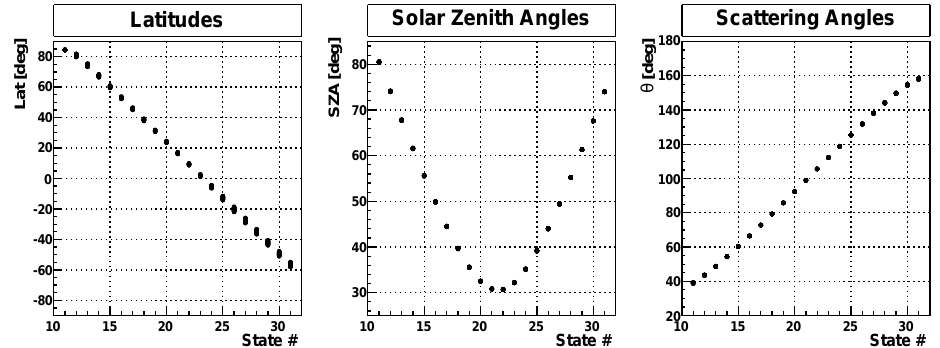
Fig. 1. Latitudes (left panel), SZA (middle panel) and single scattering angles for the data set used in this study vs. the state counter of the reference orbit 33750 (see